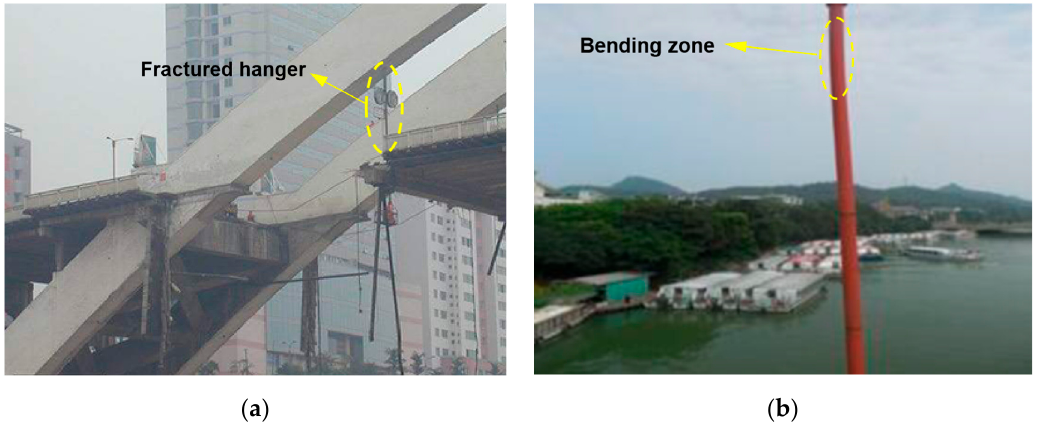
Figure 1. ( a ) Fracture of hangers of half-through and through arch bridges (HTABs and TABs); ( b ) Hangers under lateral bending.